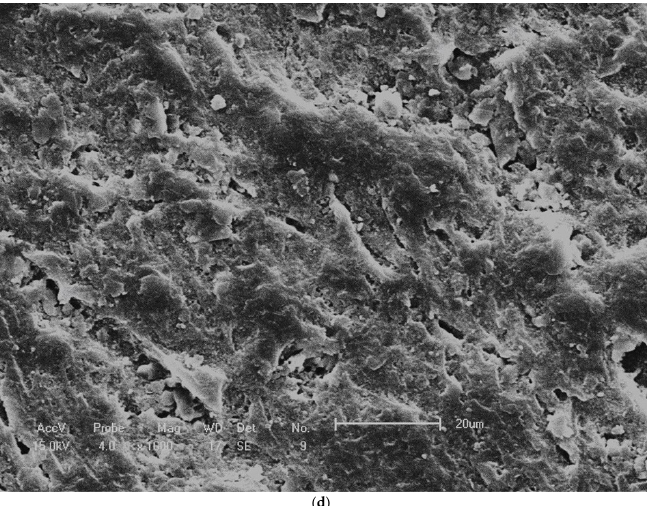
Figure 7. SEM images of PEEK surface with different pretreatments. ( a ) No treatment; ( b ) 98% sulfuric acid; ( c ) 9.5% hydrofluoric acid; ( d ) argon plasma treatment. (Reproduced from [116], with permission from © 2014 Elsevier). Bötel et al. [122] evaluated the impact of oxygen and argon/oxygen low-pressure plasma on the shear bond strength (SBS) between different PEEK compounds and three types of veneering cements. Employing the oxygen process gas for a duration of 35 min was shown to be optimal. The effects of the low-pressure plasma compound of argon/ox- ygen gases between shear bond strength of three types of PEEK (unfilled, ceramic-filled and pigment powder-filled PEEK) and veneering composites were studied by Schwitalla et al. [123]. Meanwhile, through this method in combination with sandblasting, a favora- ble enhancement in shear bond strength was achieved, especially on unfilled PEEK. In addition to helium, oxygen and argon, the influence of other types of gases, such as air and nitrogen, on the improvement of PEEK bonding properties has also been stud- ied. For example, Younis et al. [120] showed that plasma treatment of nitrogen gas exerted a positive influence on the SBS of unfilled PEEK and veneering composites. Similar results after nitrogen gas plasma treatment were obtained by Fedel et al. [124]. Therefore, plasma treatment was a suitable surface treatment to improve the bond strength of PEEK materi- als to dental composites.